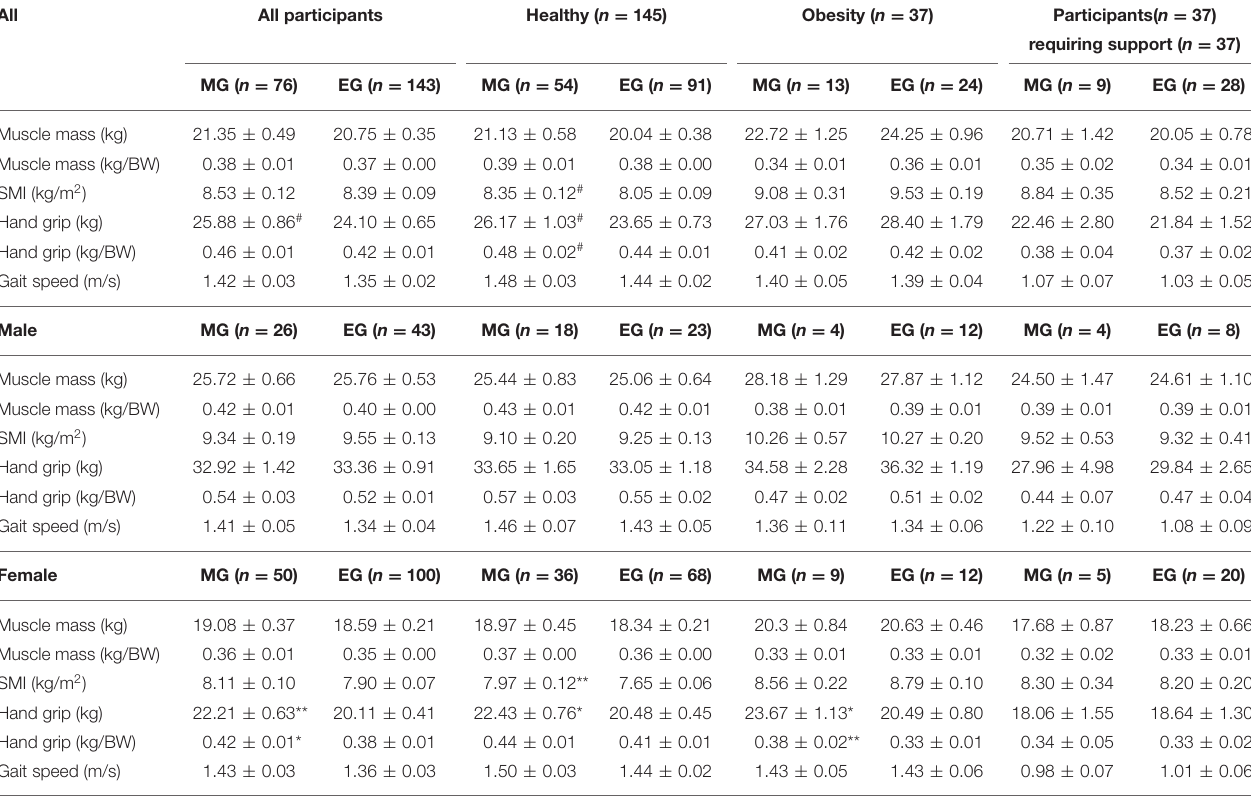
TABLE 1 | Comparison of sarcopenia-related factors between MG and EG (cross-sectional study 1). All All participants Healthy ( n =